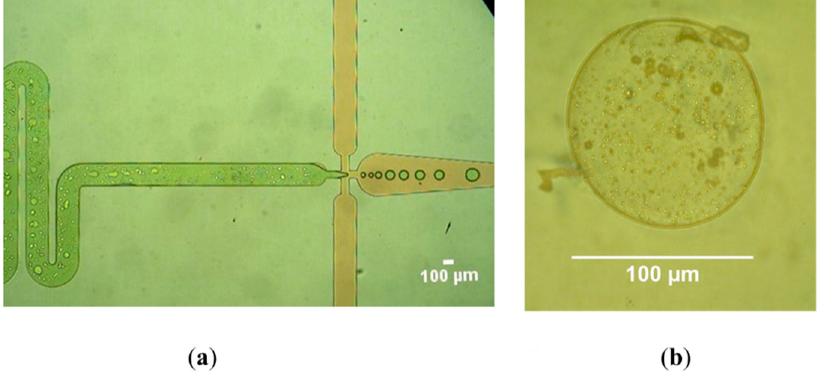
Figure 9. ( a ) Particle generation with microfluidics with a flow-focusing-based microfluidic droplet generator (MFDG). Particle formation was carried out with an own-developed hydrodynamic-focusing-based microfluidic device. ( b ) Emulsion coacervated particle fabricated using